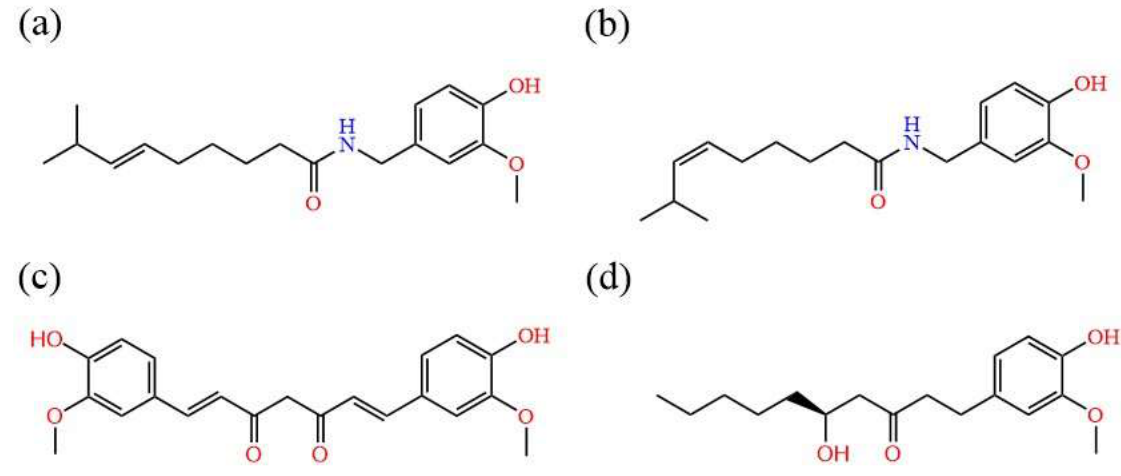
Figure 1. Molecular structural of ( a ) capsaicin, ( b ) zucapsaicin, ( c ) curcumin, ( d ) 6-gingerol.